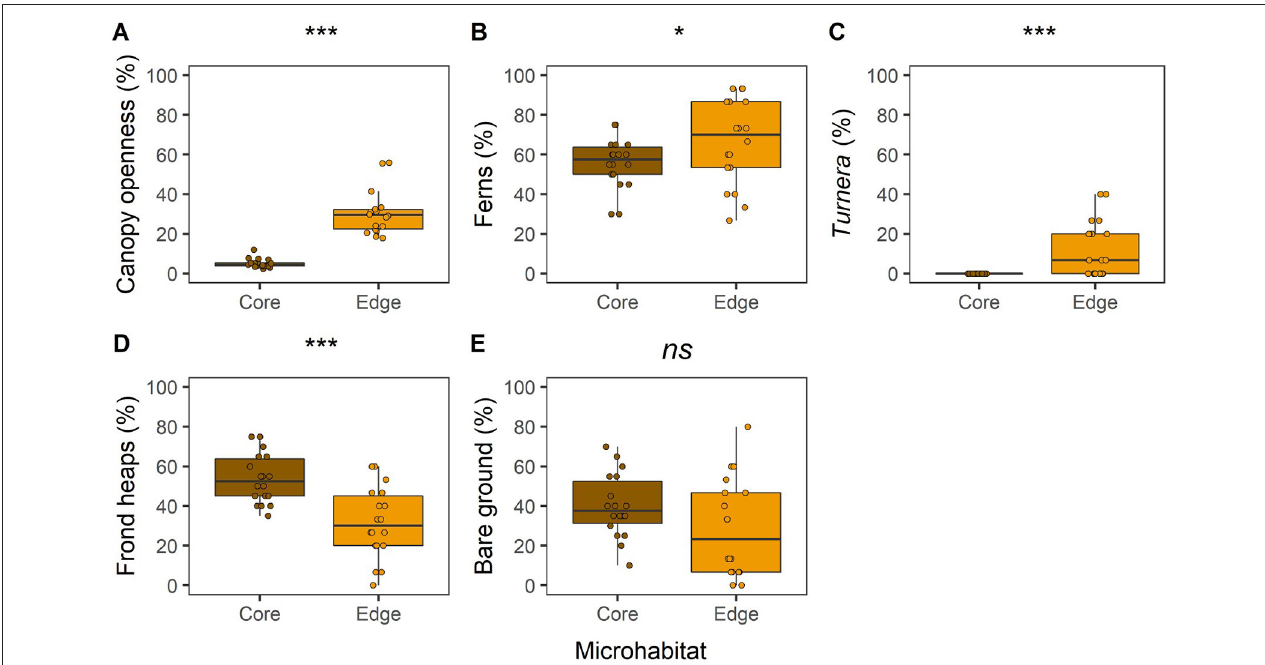
FIGURE 5 | Boxplots to show differences in percentage canopy openness (A) ; fern occurrence (B) ; Turnera ulmifolia beneficial plant occurrence (C) ; dead palm frond occurrence (D) ; and bare ground occurrence (E) , between “transect vegetation data” surveyed at Core (the 50 × 50m recording box) and Edge (plot boundary) microhabitats of the BEFTA Understory Vegetation Project plots. Occurrence values give the percentage of the 10m sampling points at which each vegetation type was found. In each case, data were collected from across all plots (Normal, Enhanced, and Reduced) during the pre-treatment time period, and therefore all plots were being managed in the same way (Normal, “business-as-usual”). The boxplots indicate median, and interquartile ranges across plots, with all raw data points ( n = 18 plots) overlaid as coloured circles. Asterisks above boxplots indicate results of LLRT comparisons for differences between Core and Edge microhabitats: *** p < 0.001; * p < 0.01; and ns , not